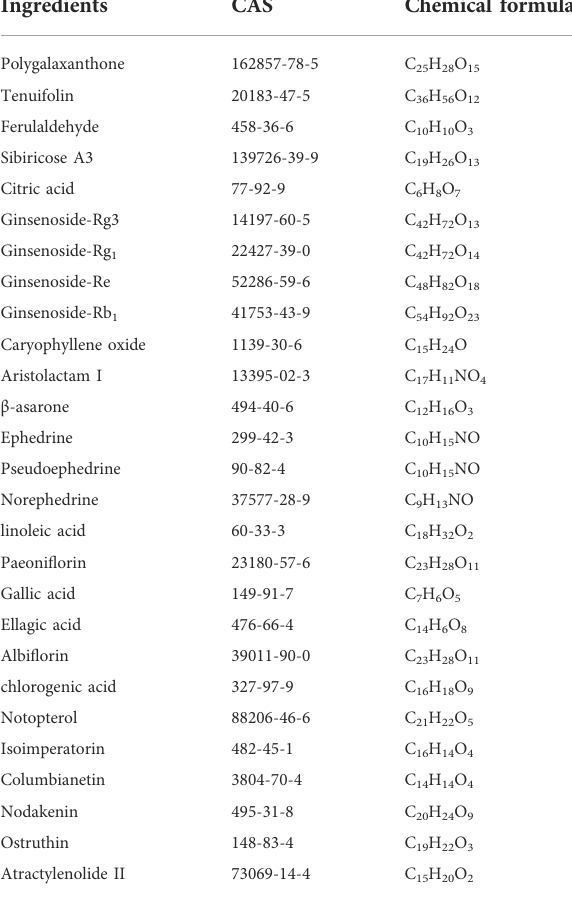
TABLE 1 The main active ingredients of